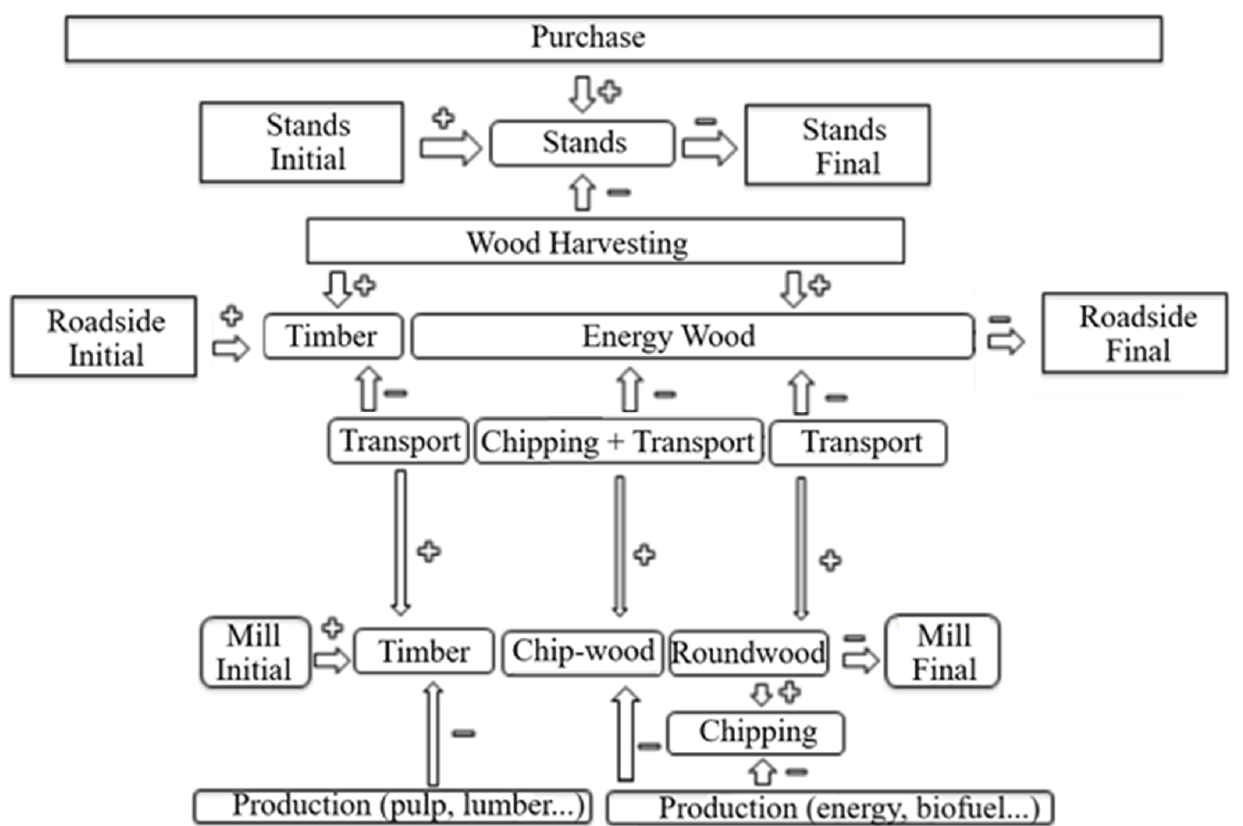
Figure 1. Wood flow model of wood procurement in an integrated material and energy industry.